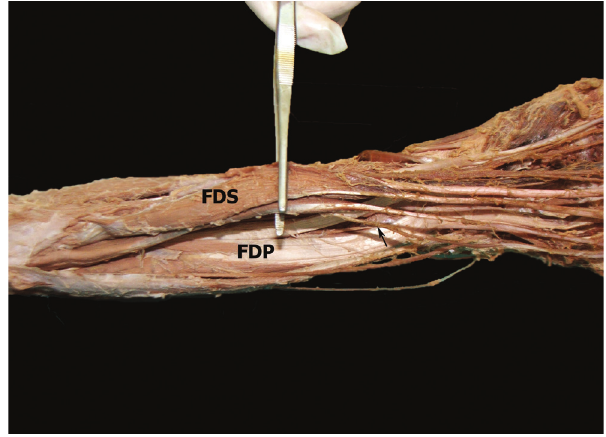
Figure 3 - Anterior aspect of the left forearm. FDS: fl exor digitorum super-FDS: flexor digitorum super- ficialis, FDP: flexor digitorum profundus. Black arrow indicates the FDP tendon originating from the FDS muscle